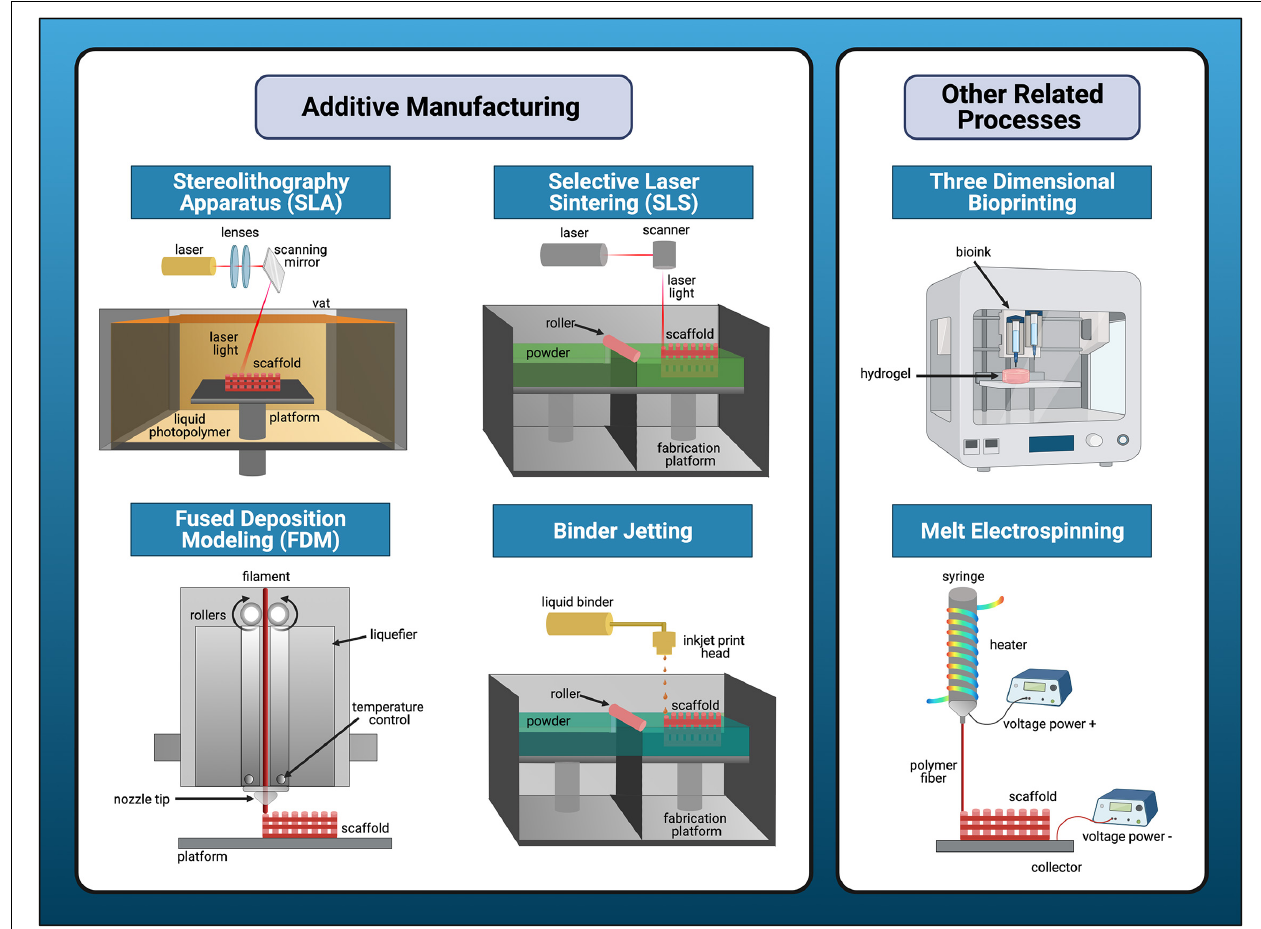
FIGURE 4 | Overview of major types of additive manufacturing processes for bone tissue engineering applications. Additive manufacturing (AM) falls into three major categories: laser-based, extrusion-based, or binder jetting processes. Stereolithography apparatus (SLA) and selective laser sintering (SLS) are the predominant forms of laser-assisted techniques for production of non-metallic bone scaffolds. Fused deposition modeling (FDM) is the main extrusion-based method and binder-jetting is the last method. Melt electrospinning or bioprinting are similar, but distinct scaffold fabrication processes that may be used in conjunction with traditional methods of